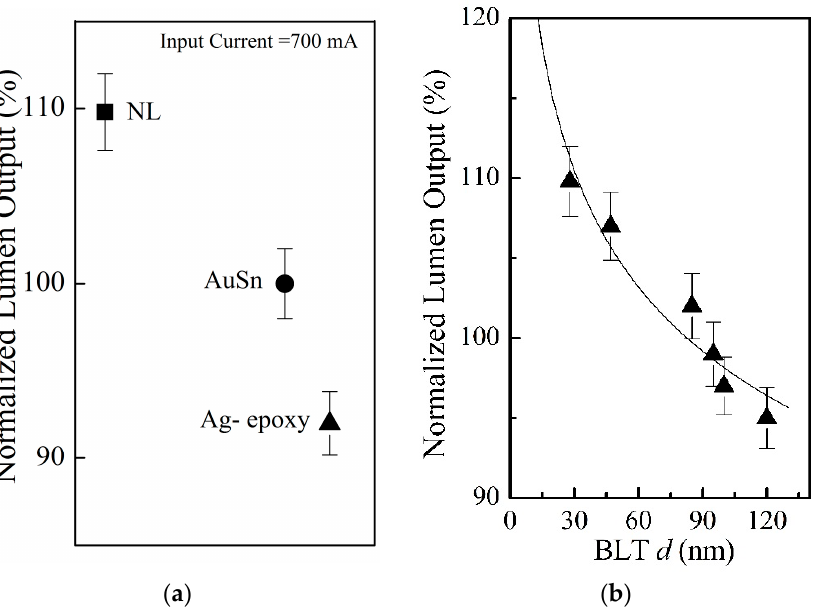
Figure 6. ( a ) Normalized lumen output of the devices made by three different die-substrate bonding methods at an input current of 700 mA: the solid square symbol ( ■ ) represents the NL bonding approach with BLT = 28 ± 5 nm, the solid circle symbol ( ● ) represents AuSn bonding with an industrial standard BLT value of 20 ± 2 μ m, the solid triangle symbol ( ▲ ) represents Ag-epoxy bonding with an industrial standard BLT value of 25 ± 2 μ m. ( b ) For the devices made by the NL bonding, the normalized lumen output ( 𝐼 (cid:3040) ) is found to be increase with the decreasing BLT, which can be described by I m = 1.5414 (BLT) -0.098 (the solid curve), and the solid triangle symbol ( ▲ ) represents the experimental data for normalized lumen output ( 𝐼 (cid:3040) ).